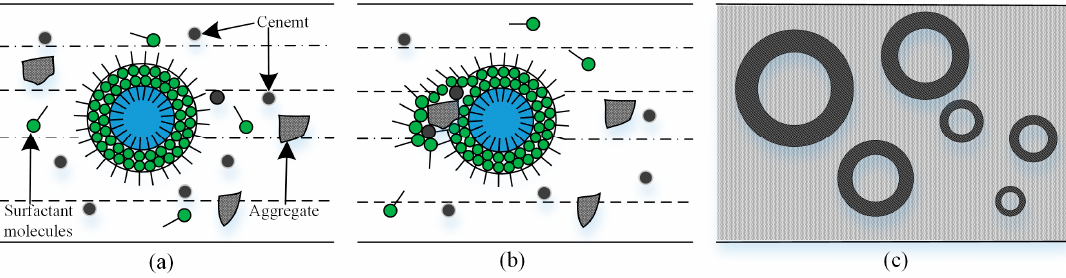
Figure 4. Formation process of foam slurry: ( a ) mixture, ( b ) stirring and adhesion and ( c ) foam slurry formation.